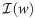
Total information flow as a function of time.The behavior of the total information flow I(w), defined in Eq (6), at different time scales δ. Each time window w is 500 days long. The date associated to each w is the middle of the time window considered. The x-axis tick marks represent the first of March of every year. While at short time scales (less than 3 days) we observe a peak around the two major financial crises of the last decades, this effect fades away as δ increases. Interestingly, the results at δ = 2 carries much more information than those at δ = 1.